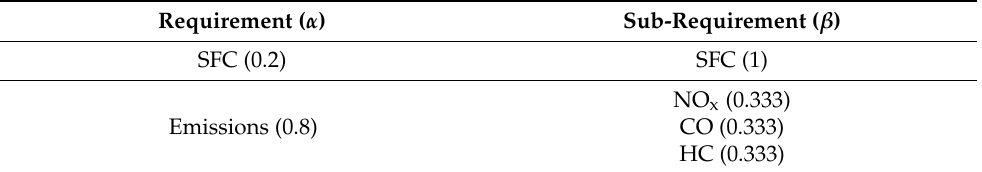
Table 2. Criteria weights, per unit